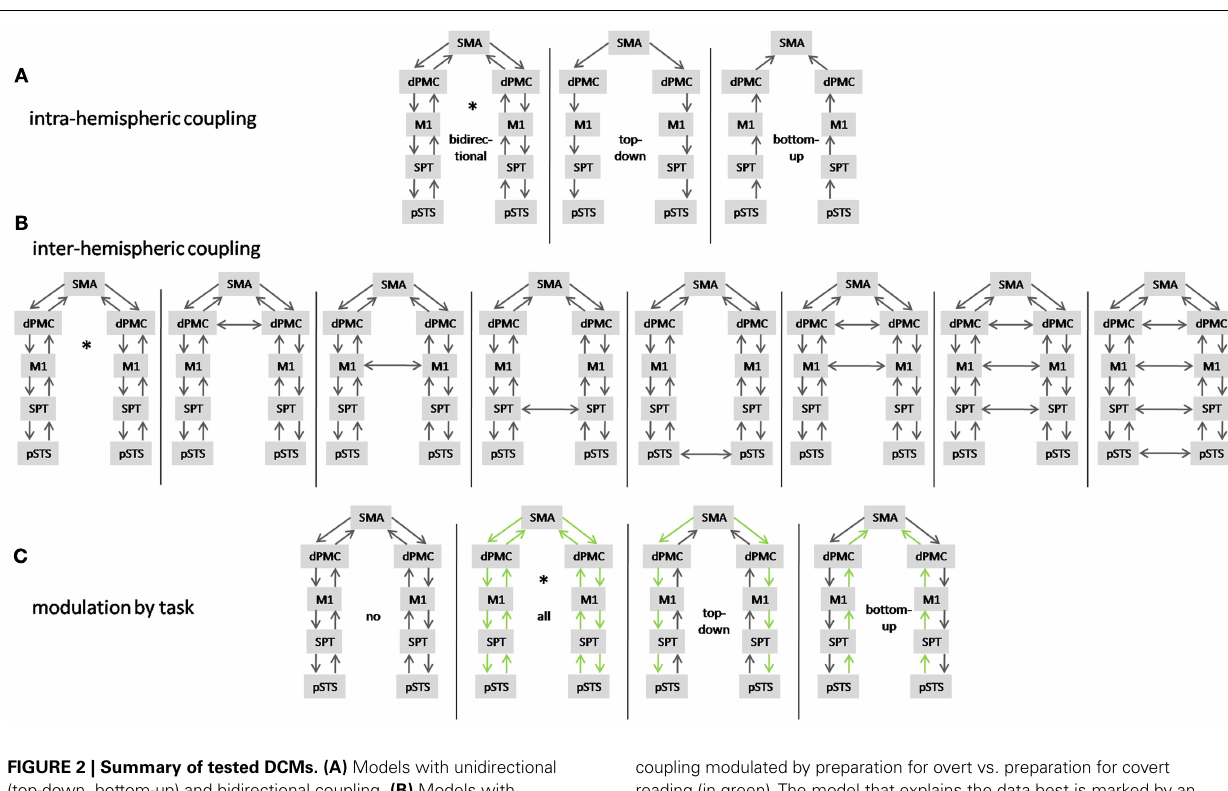
coupling modulated by preparation for overt vs. preparation for covert reading (in green).The model that explains the data best is marked by an